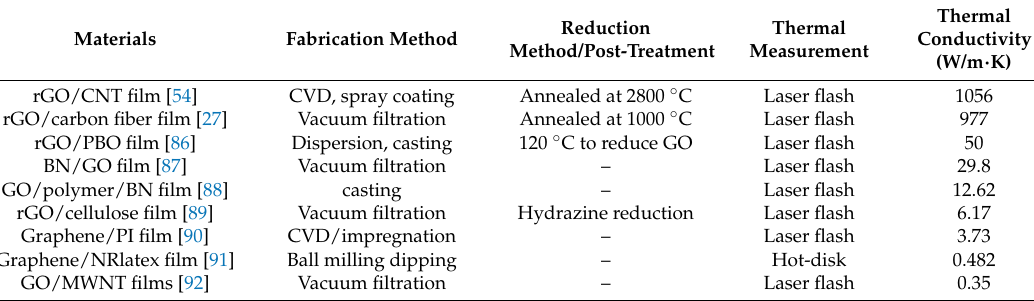
Table 2. Summary of the graphene composite films combined with different